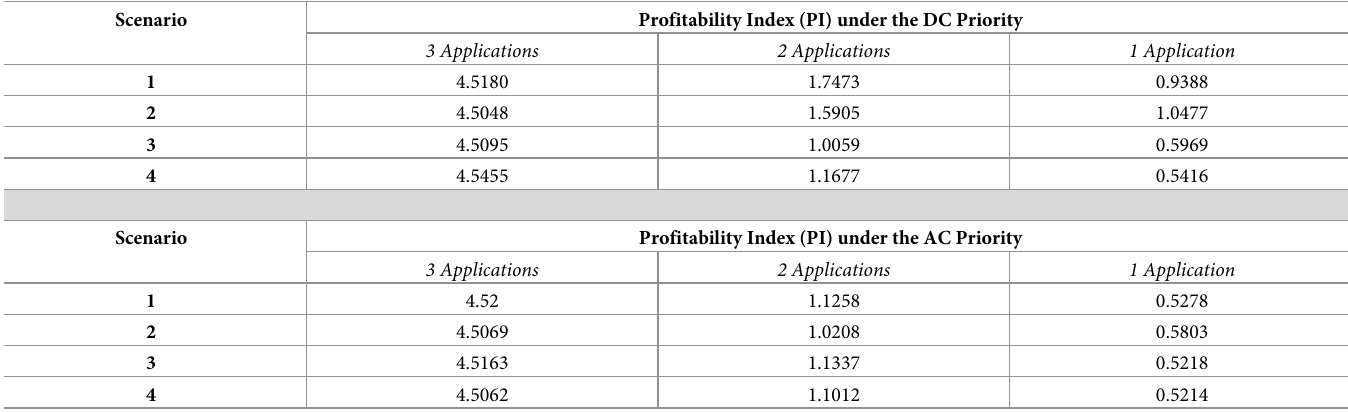
Table 3. PIs of different application combinations: 3 applications (EVCS, FR, ECA), 2 applications (FR, ECA), and 1 application (ECA only).